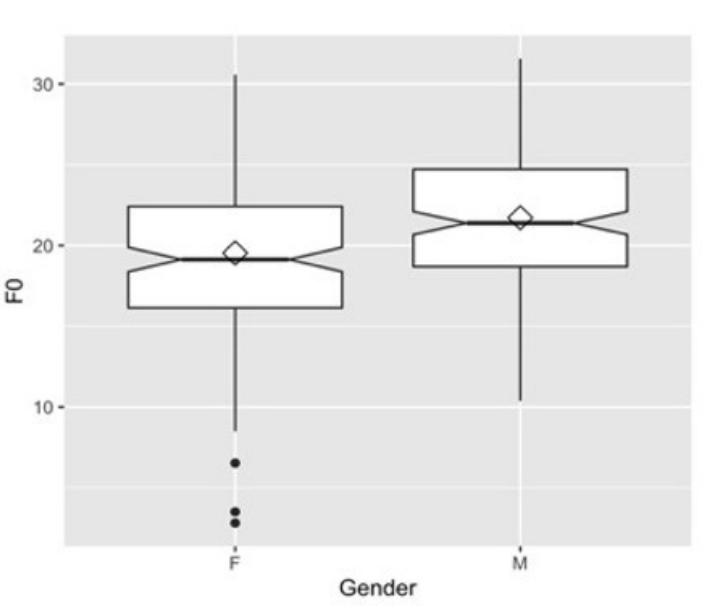
Figure 2. Box and whisker plot for F0 (in semitone) by gender.